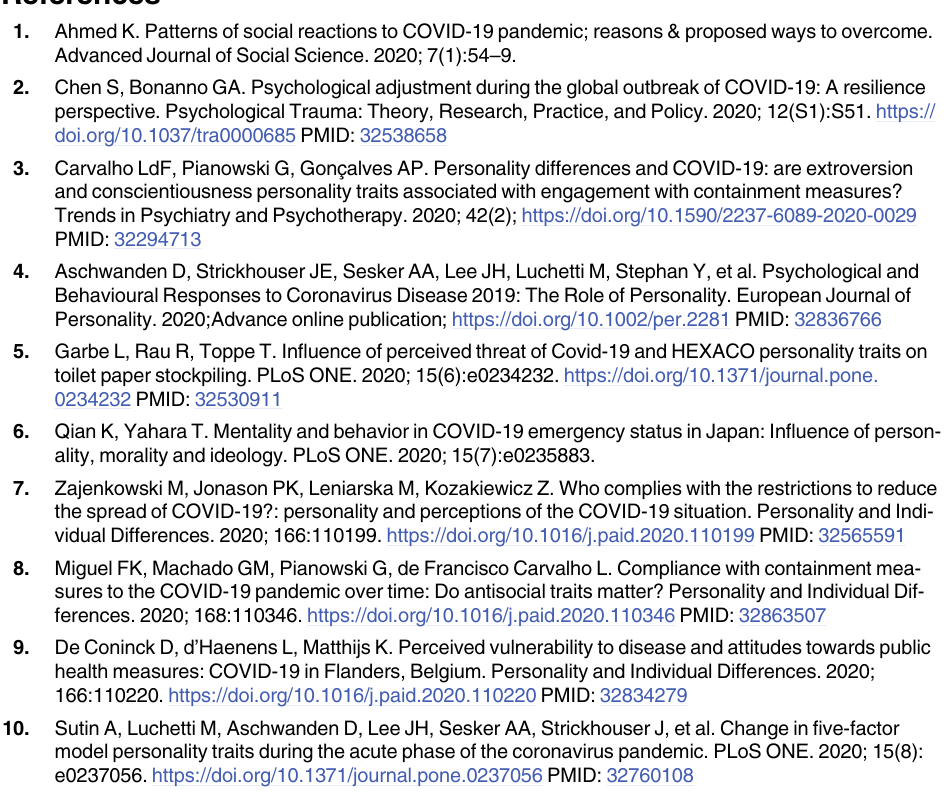
S1 Table. German translations of the English version of the International Personality Item Pool (IPIP). S2 Table. Correlations between all predictor and outcome